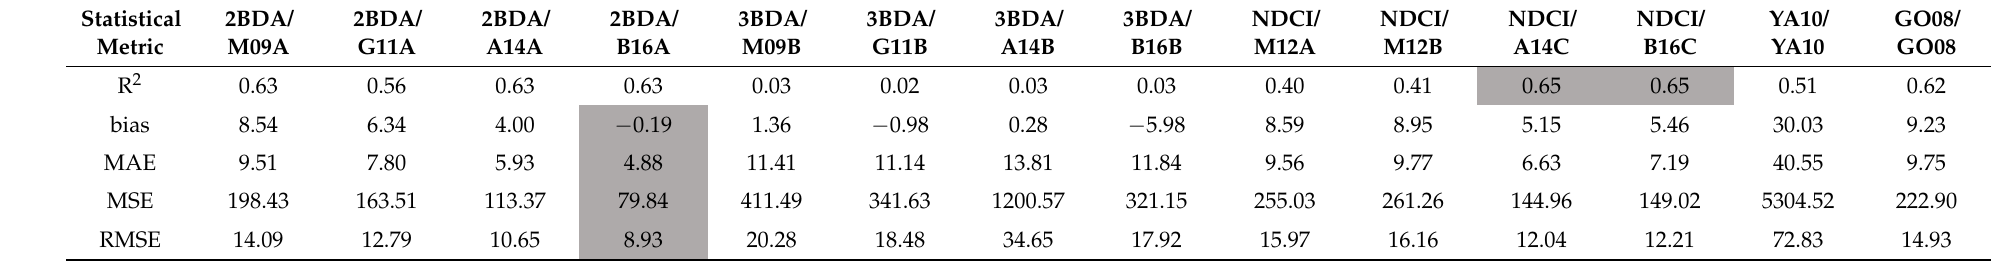
Table A5. Statistical metrics (R 2 , bias, MAE, MSE, RMSE) for different chl- a bio-optical algorithms from simulate Sentinel-2 / MSI spectral bands from proximal hyperspectral in situ data from Müritz-Havel Lakes. 2BDA with G10A calibration and 3BDA with G10B calibration did not produce results. Shaded cells indicate the best values of each metric. Statistical